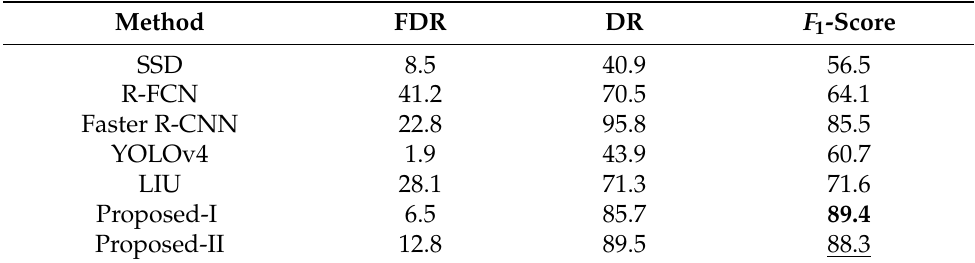
Table 6. Performance comparison (%) on the testing set for SSD, R-FCN, Faster R-CNN, YOLOv4, LIU, Proposed-I and Proposed-II, where values in bold and underlined denote the best and second best results, respectively. The backbone networks of all the detectors were VGG-16.